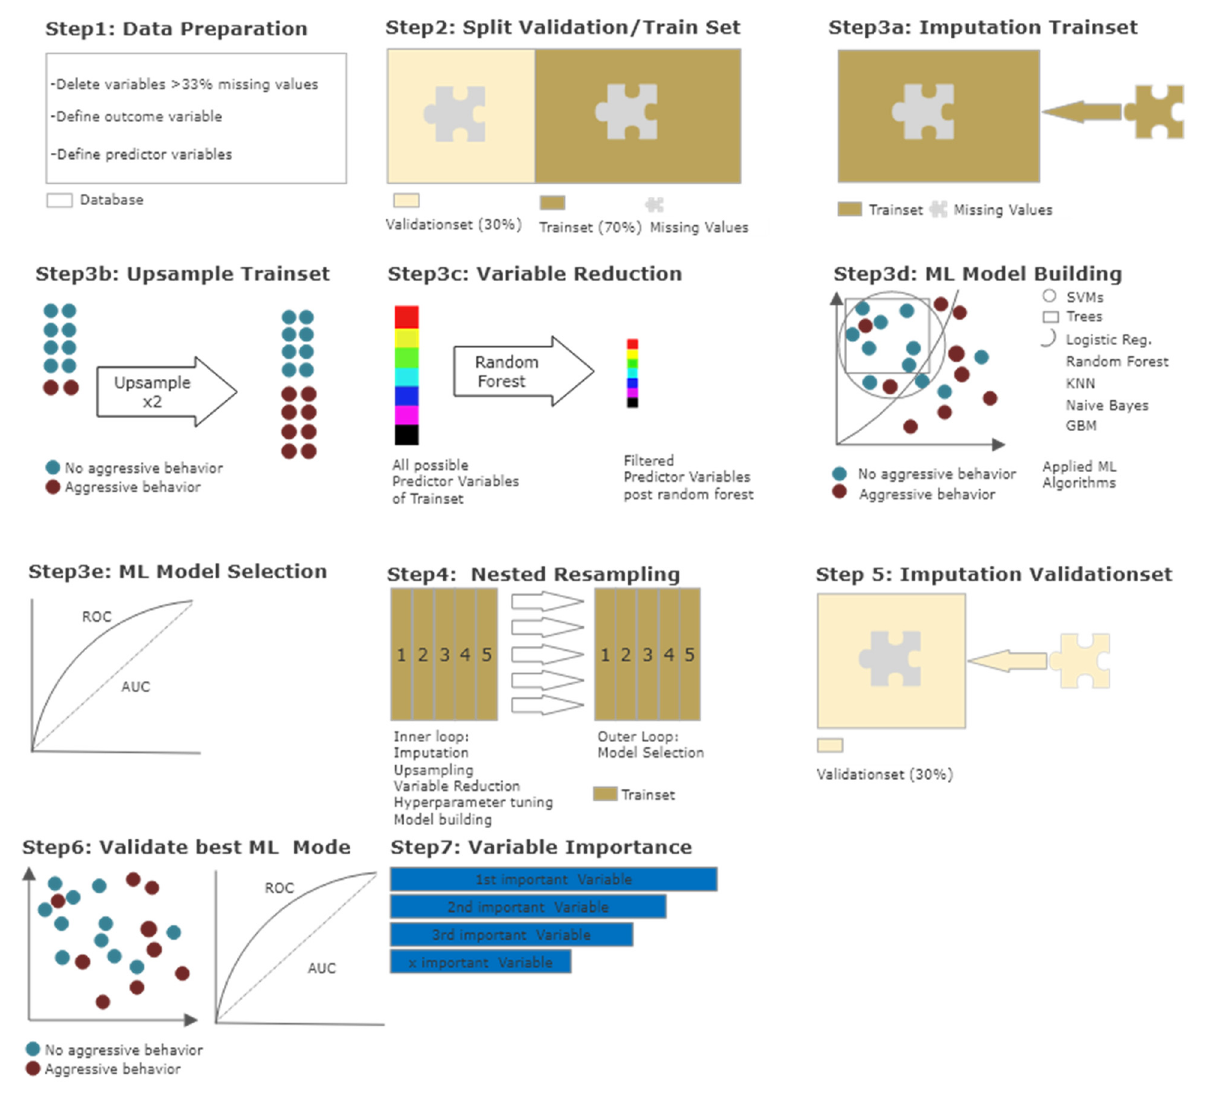
Figure 1. Overview of statistical procedures: ( Step 1 )—Data Preparation: Multiple categorical vari- ables were converted to binary code. Continuous and ordinal variables were not manipulated. Out-